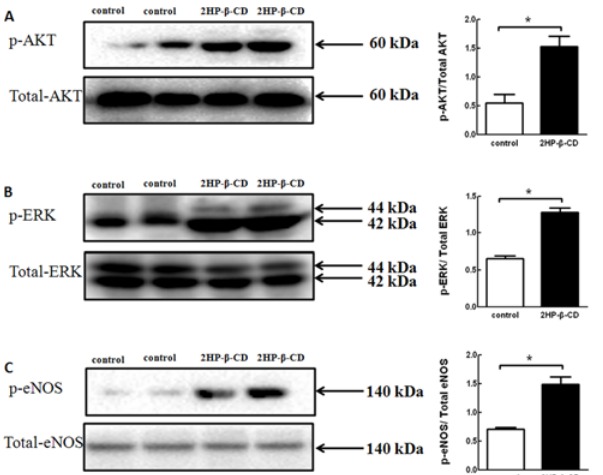
Fig 6. Phosphorylation of Akt, ERK and eNOS in ischemic muscle following injections of 2HP- β -CD or PBS. Muscle tissue homogenates from 2HP- β -CD-treated (filled) and PBS-treated (open) mice at post- operative day 28 were subjected to western blot using antibodies against phospho-Akt and total Akt (A), phospho-ERK and total ERK (B), and phospho-eNOS and total eNOS (C) as described in “ Materials and Methods ” . The quantitative analyses of band densities are also shown. Data represent the mean ± S.E.M. ( n = 5 mice per group). * p < 0.05, versus the PBS-treated control mice.